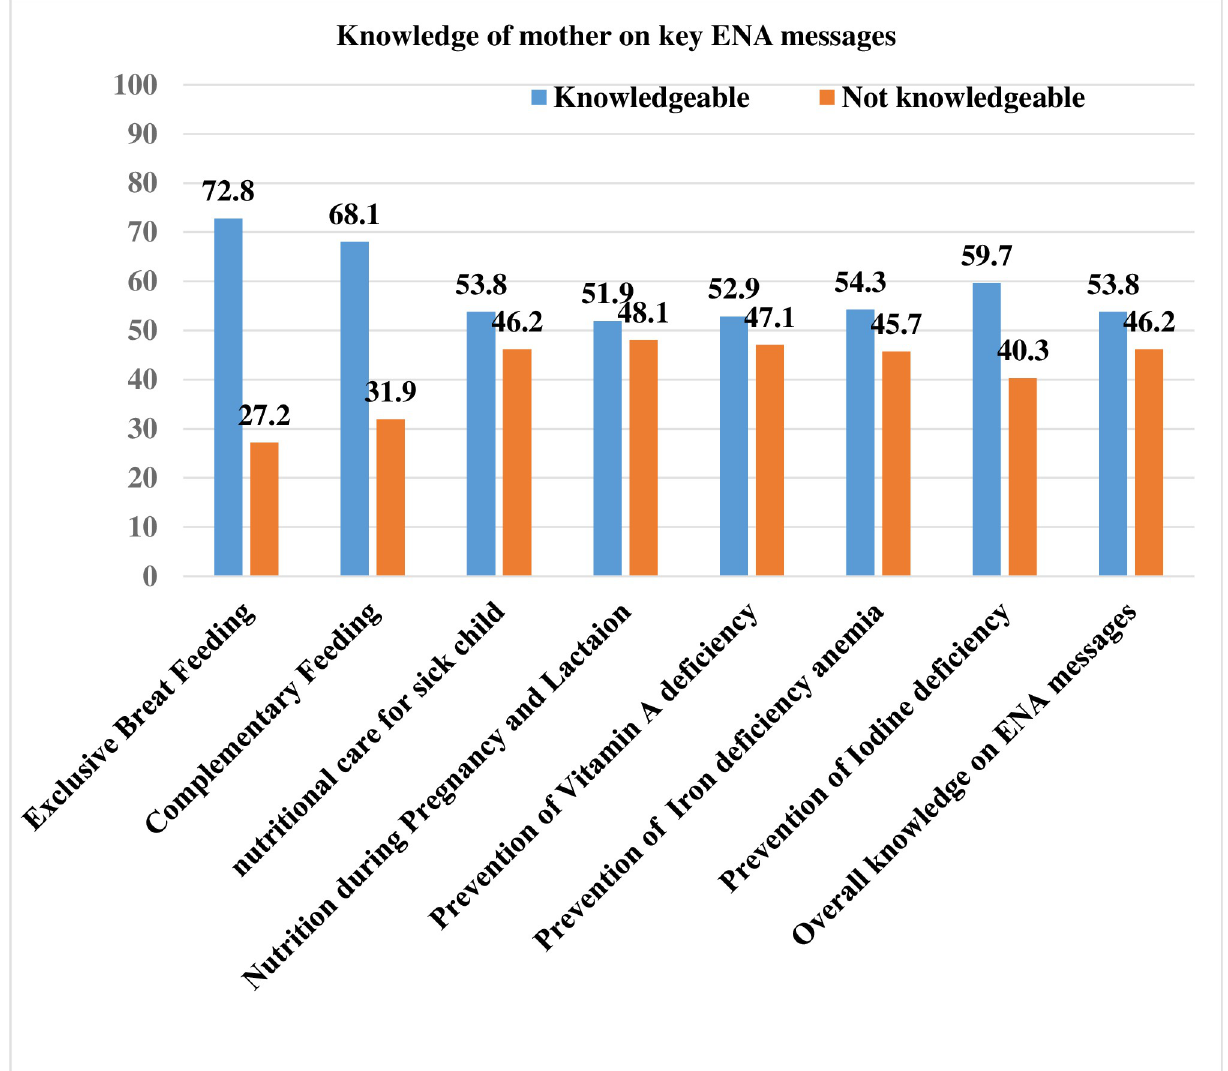
Fig 1. Knowledge of mothers towards key ENA messages in Lemo District, Southern Ethiopia, 2021.